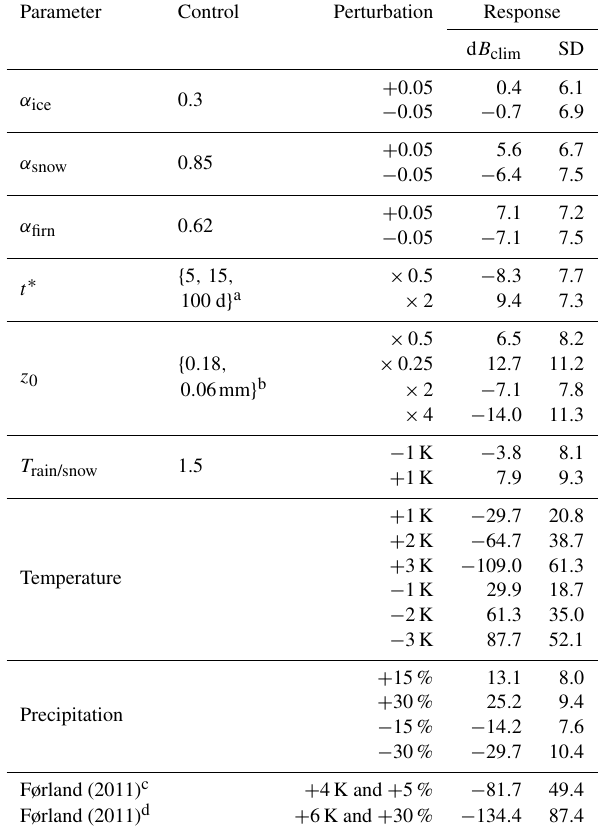
Table 8. Sensitivity of the climatic mass balance B clim in response to perturbations of model parameters and climate perturbations. d B clim (cmw . e . ) is the departure of B clim from the control run aver- aged over all stakes and years, σ (cmw . e . ) is the standard deviation of the difference for both year to year and site to site. α is albedo, t is ageing factor for snow albedo, T rain/snow is rain snow threshold, z 0 is roughness lengths for momentum necessary for calculating the turbulent heat fluxes. Climate experiments are given by uniform air temperature shifts (K) and precipitation increases (%), but for the last two experiments we apply seasonal differences; see text for ex-